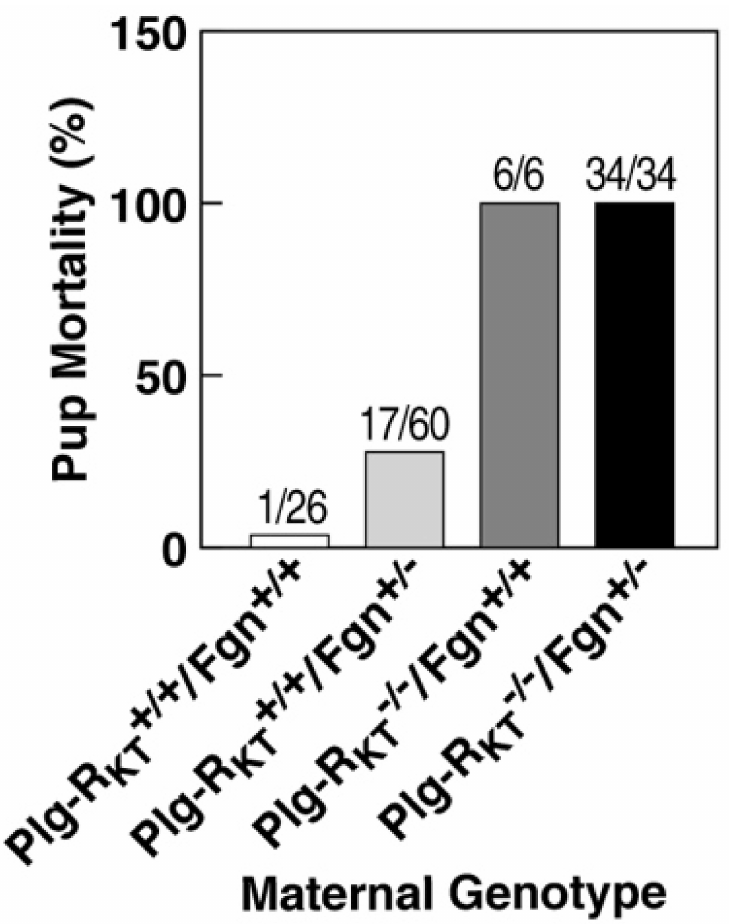
Figure 7. Effect of fibrinogen heterozygosity on alveolar development and lactational competence in Plg-R KT − / − mice. Pup mortality at day 2 postpartum as a function of maternal genotype. This re- search was originally published in Miles, L.A.; Baik, N.; Bai, H.; Makarenkova, H.P.; Kiosses, W.B.; Krajewski, S.; Castellino, F.J.; Valenzuela, A.; Varki, N.M.; Mueller, B.M.; Parmer, R.J. The plas- minogen receptor, Plg-RKT, is essential for mammary lobuloalveolar development and lactation. J. Thromb. Haemost. 2018 , 16 , 919–932. [83] Reprinted with permission from John Wiley and